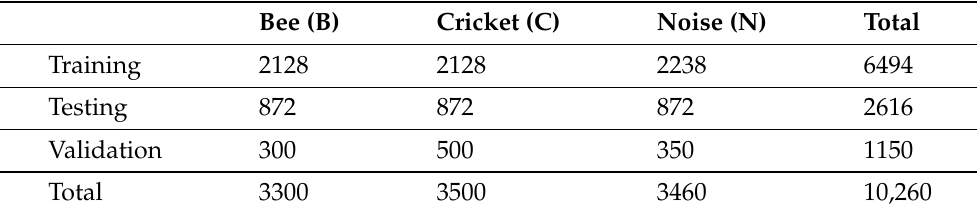
Table 1. Audio sample distribution in BUZZ1.